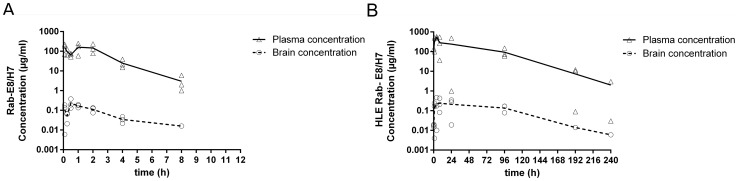
Mean brain and serum concentration of Rab-E8/H7 and HLE Rab-E8/H7.Individual brain (circles) and serum (triangles) concentrations and mean values (lines) of HLE Rab-E8/H7 (A) and Rab-E8/H7 (B) upon intraperitoneal injection of 5 mg HLE Rab-E8/H7 or 10 mg Rab-E8/H7.